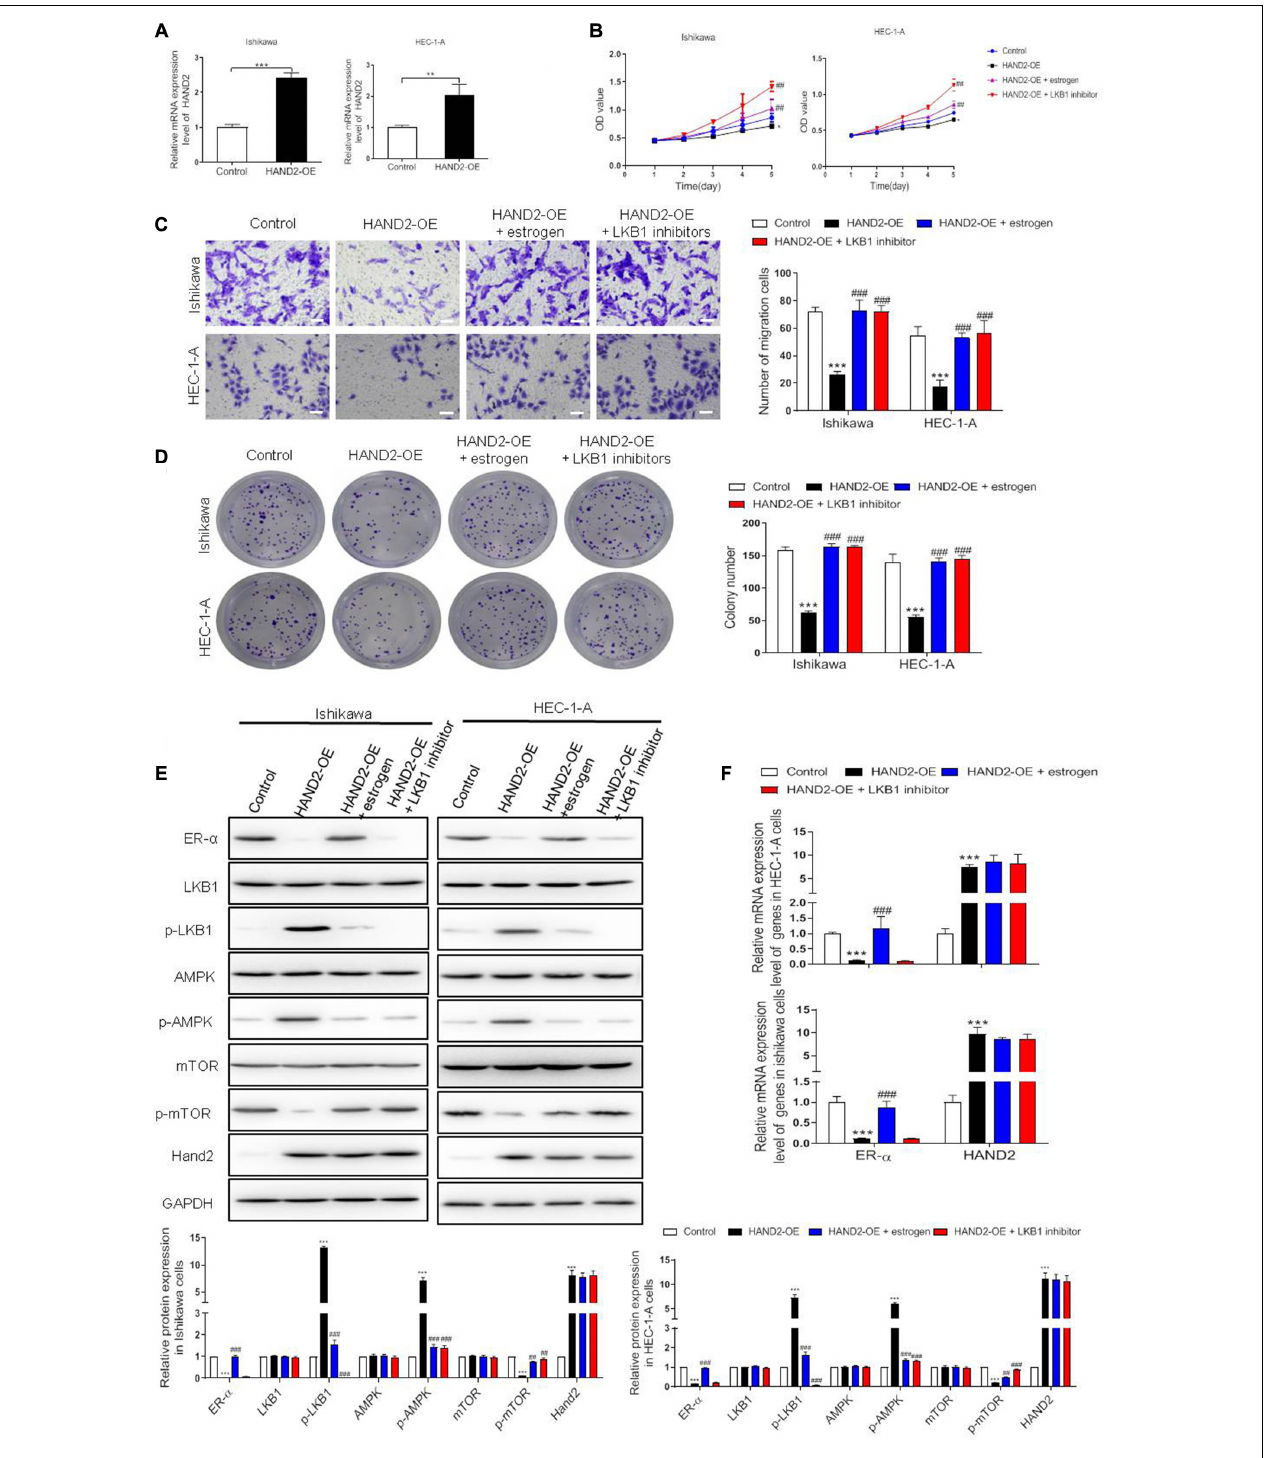
FIGURE 5 | Effect of HAND2 on the proliferation of Ishikawa and HEC-1-A cells. (A) The efficiency of HAND2 overexpressed (HAND2-OE) vector transfection was assessed by qRT-PCR analysis. (B) These cells transfected with the Hand-OE vector and combining treatment with estrogen (10 nM) or LKB1 inhibitor (380 nM). Cell viability was assessed using CCK-8 assay. (C,D) The migration and colony formation assays were performed in these cells after different treatments. Bar = 20 µ m. (E) Representative blot and analyses were performed for the protein levels of ER- α , LKB1, p-LKB1, AMPK, p-AMPK, mTOR, p-mTOR, and HAND2 in these cells. (F) The mRNA levels of ER- α and HAND2 were performed by qRT-PCR analysis. The data were showed as the mean ± SD, ** p < 0.01, *** p < 0.001 vs. the control group; ## p < 0.01, ### p < 0.001 vs. the HAND2-OE group.